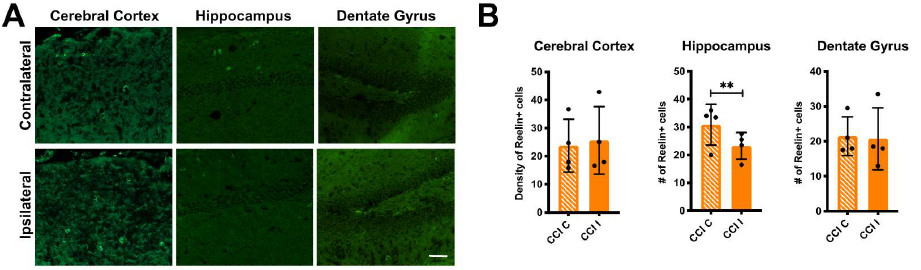
Figure 5. Loss of hippocampal Reelin + cells 7d post-CCI. ( A ) Representative images of contralateral and ipsilateral brain sections immunolabeled with Alexa Fluor 488-conjugated Reelin monoclonal antibodies. The sections were obtained from a mouse subjected to CCI 7 d after injury. Scale bar: 50 µ m. ( B ) Quantification of Reelin+ cells from n = 4 CCI mice. Each value is the average of 2–3 different sections/brain. Data in the cerebral cortex represent the average density of Reelin+ cells (number of cells/six ROIs), whereas data in the hippocampus and dentate gyrus represent the total number of cells counted in the entire structure. Statistical analysis was conducted comparing contralateral (C) to ipsilateral (I) values using paired t -tests. The number of Reelin+ cells was significantly reduced by CCI in the hippocampus proper, but not in the cerebral cortex or dentate gyrus. Scatter dot plots show individual data points and the mean values +/- SD. ** p < 0.01.